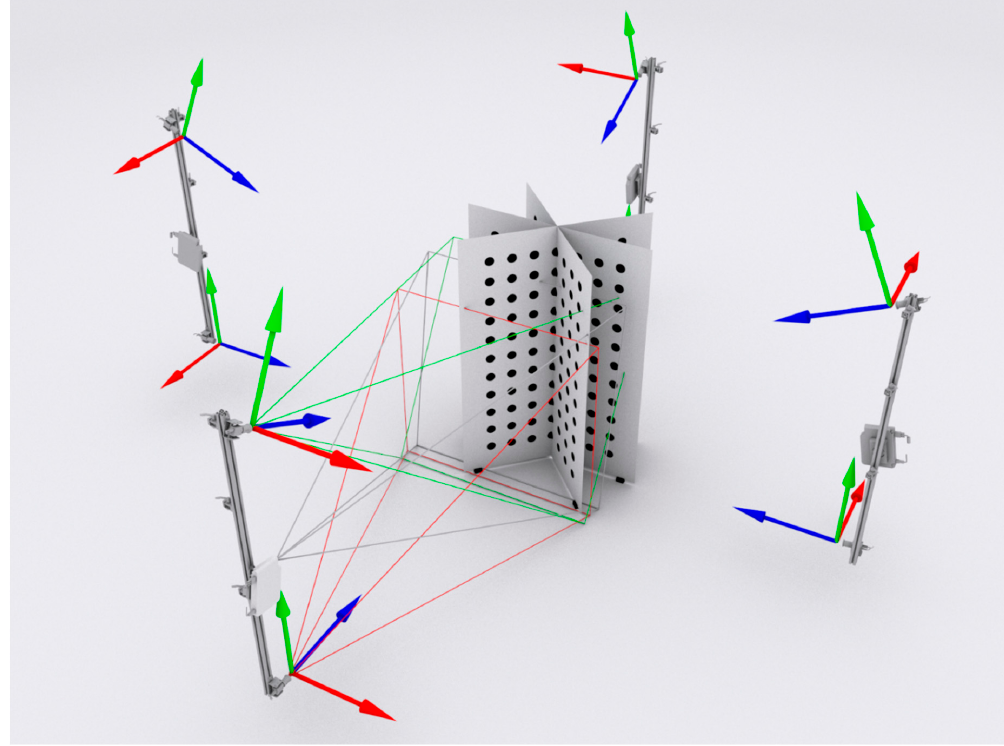
Figure 12. Calibration artefact positions employed in the validation analysis.